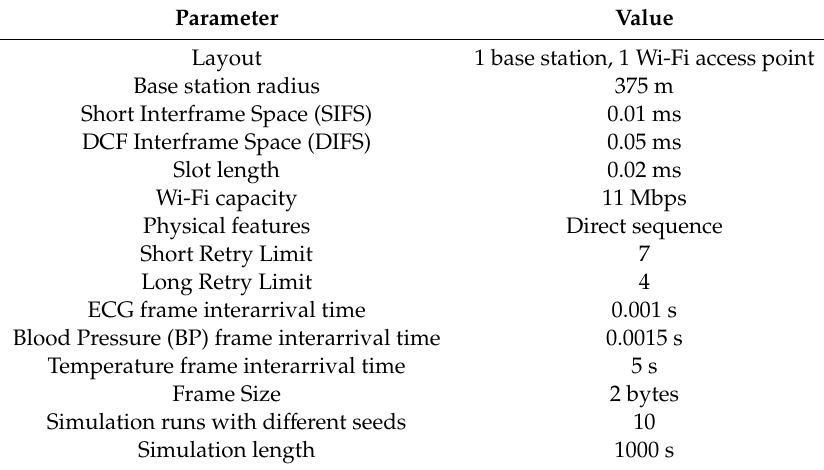
Table 3. Parameters and tra ffi c models for simulations.